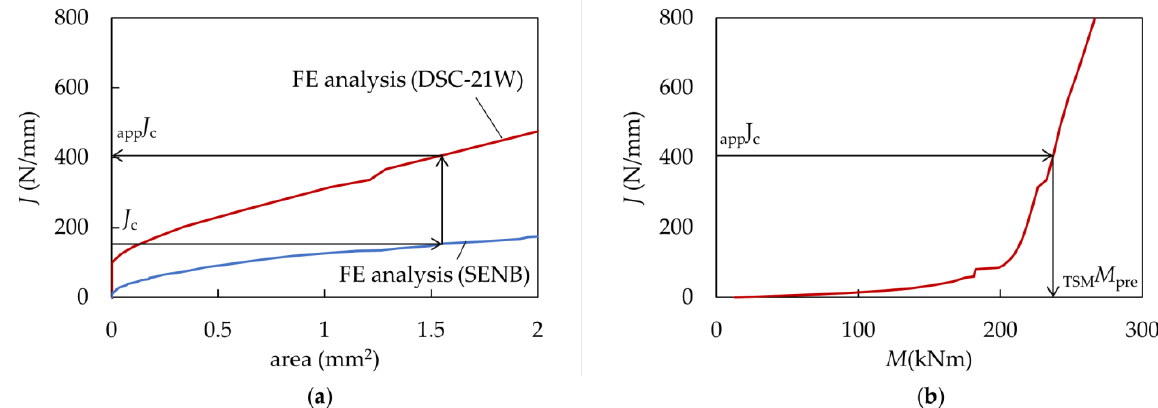
Figure 10. Moment vs. rotation curves obtained through the experimental and FE analysis.